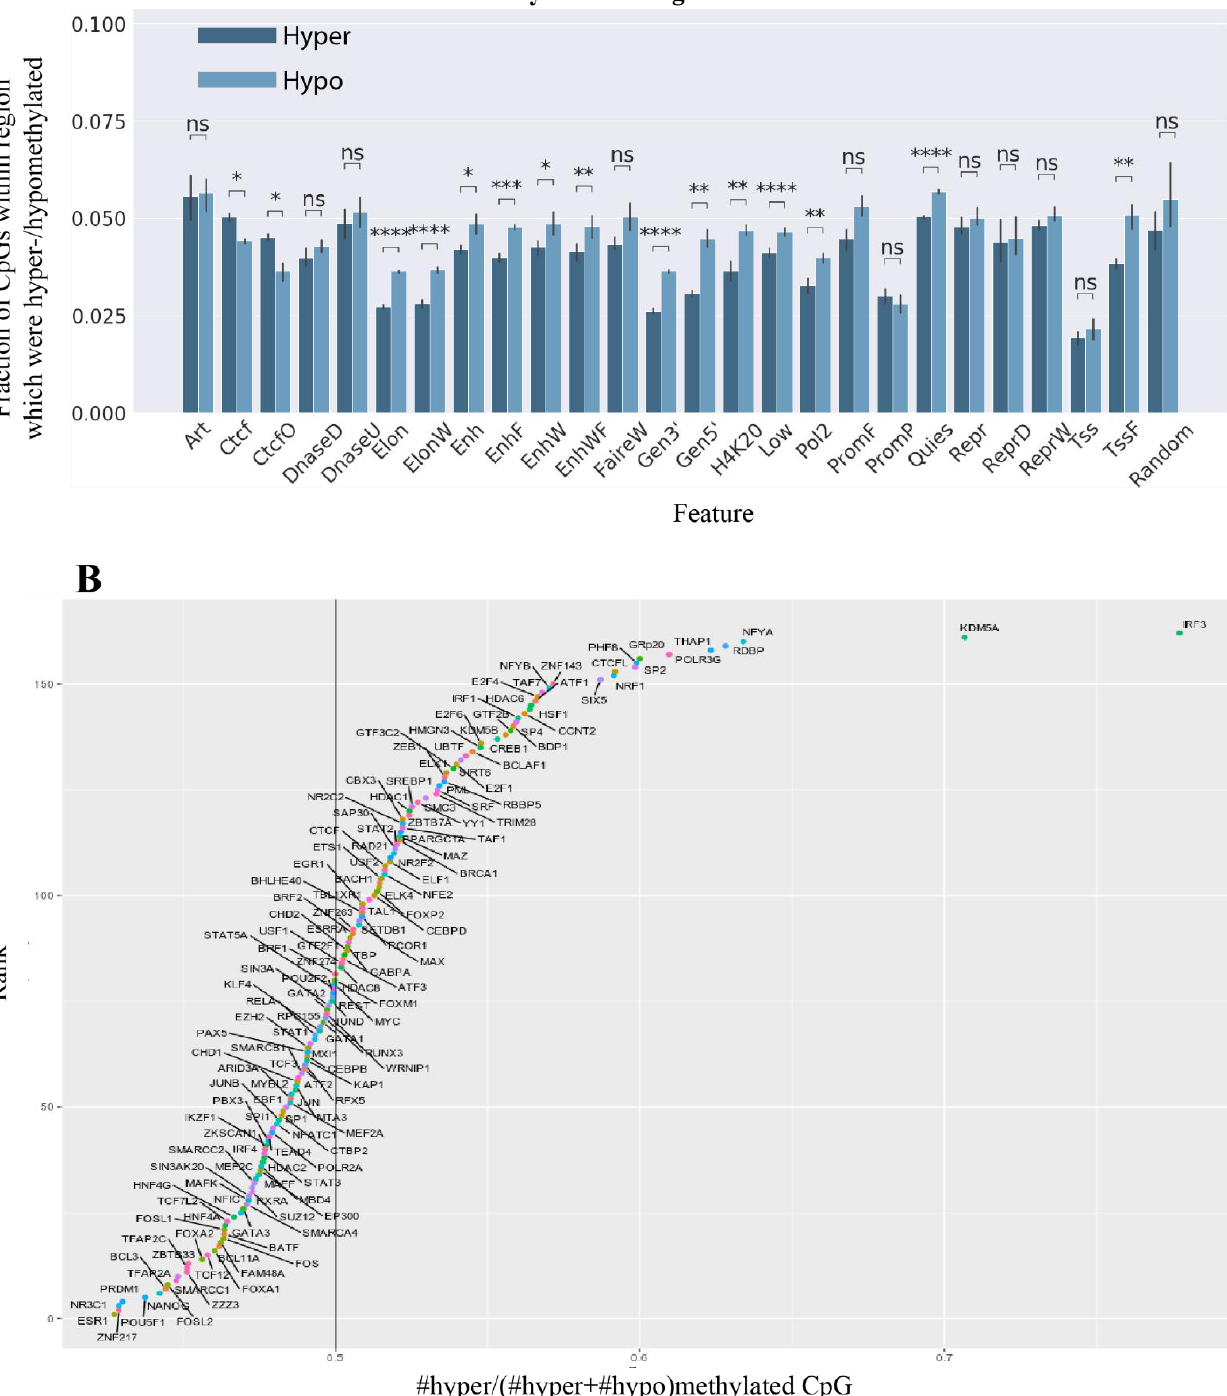
Figure 3. Distribution of hypo- and hyper-methylated CpGs within certain epigenomic features. ( A ) Region of ChromHMM genome subdividing (* p -value < 0.05, ** p -value < 0.01, *** p -value < 0.001, **** p -value < 0.0001, ns—not significant, Student’s t -test). ( B ) For indicated transcription factors we estimated the fraction of hypo- and hypermethylated sites among all CpGs with significantly altered methylation.